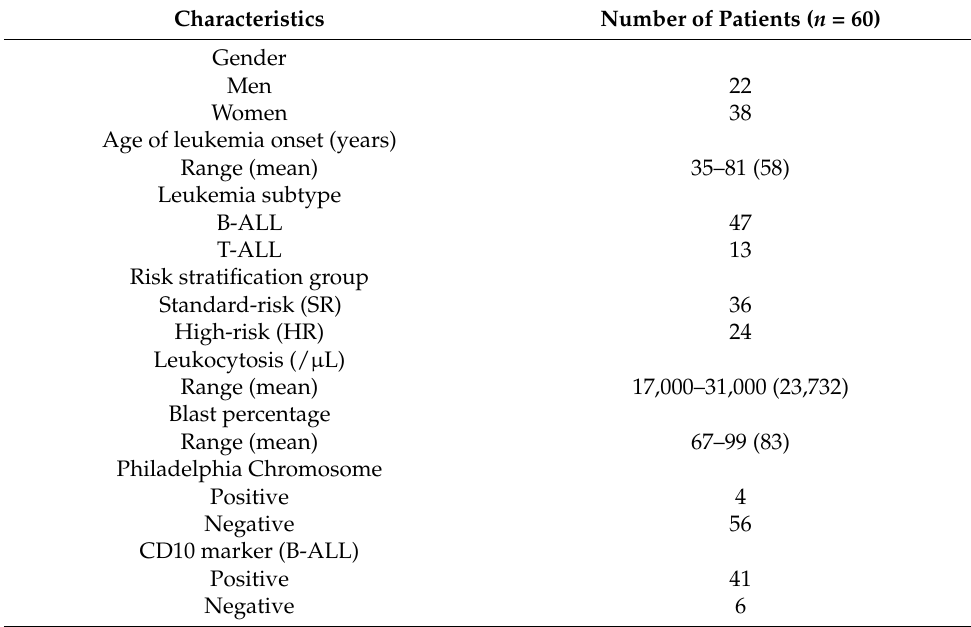
Table 1. Demographic and clinical characteristics of patients.